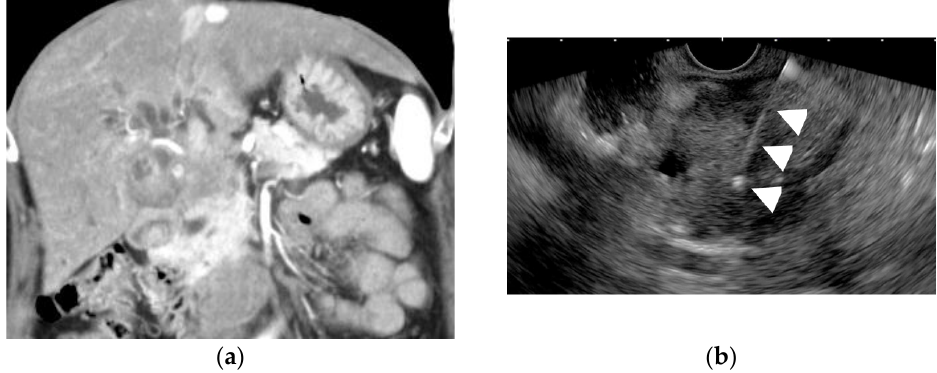
Figure 9. Endoscopic ultrasound-guided fine-needle aspiration (EUS-FNA) for a GB lesion. ( a ) Enhanced CT scan shows a GB lesion. ( b ) EUS-FNA of a GB mass lesion. The arrowhead shows the FNA needle inside the lesion. The pathology result showed adenocarcinoma.